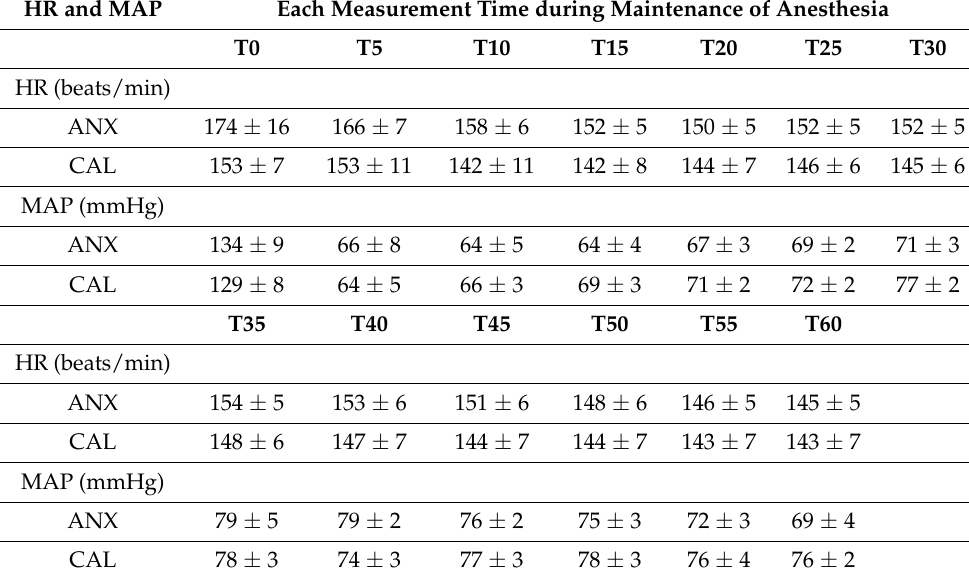
Table 2. The value of HR and MAP at each measurement time. HR and